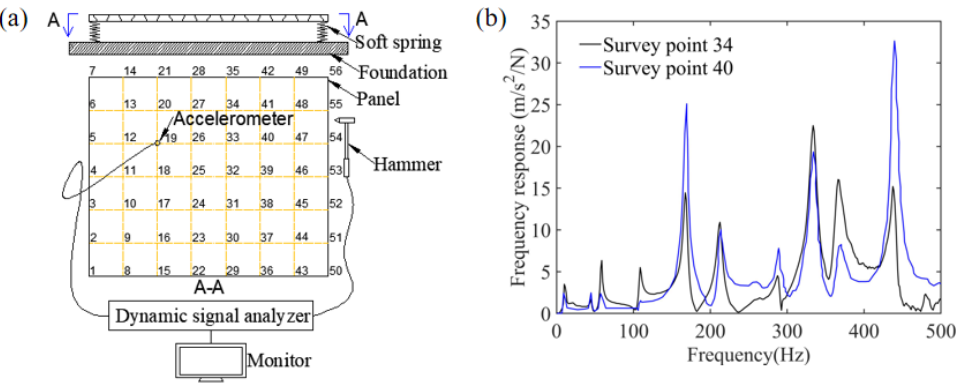
Figure 2. ( a ) Experimental equipment of mode testing. ( b ) Typical frequency response based on